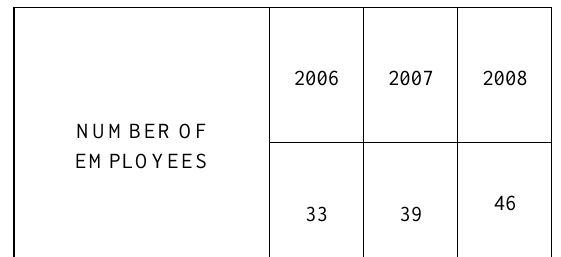
Table 2: Personnel Profile of XYZ Enterprise On a Yearly Basis